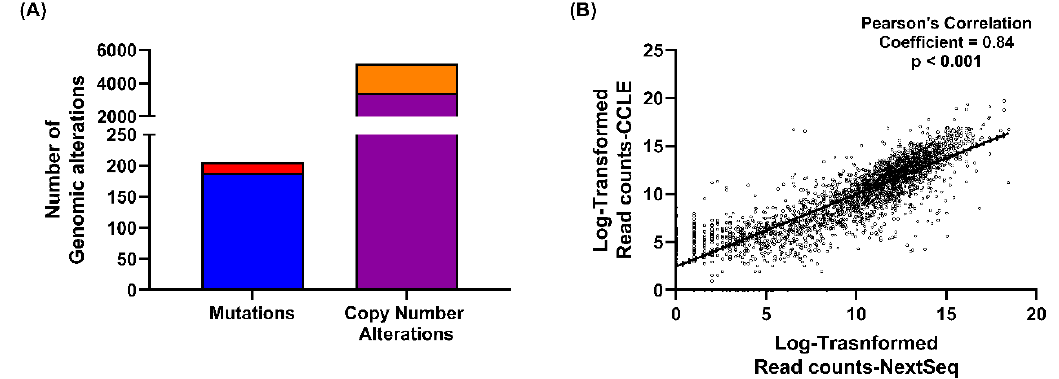
Figure 1. Confirmation of the NIH-OVCAR3 cells as representative of HGSOC. ( A ) Mutation and copy number alteration data from the CCLE database was analysed. Mutations were categorised as homozygous ( red ) or heterozygous ( blue ) using a variant allele frequency cut-off of 0.8, mutations with variant allele frequency > 0.8 were considered homozygous. The copy number alterations were categorised using their GISTIC scores of − 2 or 2 (amplifications: GISTIC score of 2 ( orange ) and deletions: GISTIC score of − 2 ( purple ). ( B ) RNA-seq read counts of 2426 genes from the CCLE database were correlated with the read counts for the same 2426 genes established from targeted RNA-sequencing to confirm authenticity of the NIH-OVCAR3 cells in our possession.